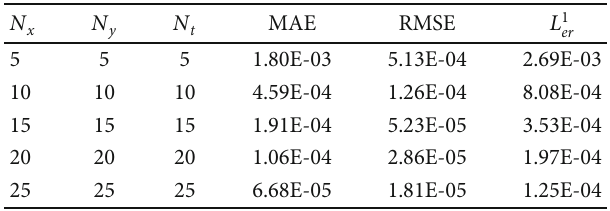
Table 11: Errors for di ff erent values of N , N , and N of Example 4 x y t = ½ 0, 1 (cid:2) = ½ 0, 1 (cid:2) 3 using ε = 0 : 1 and Ω T T